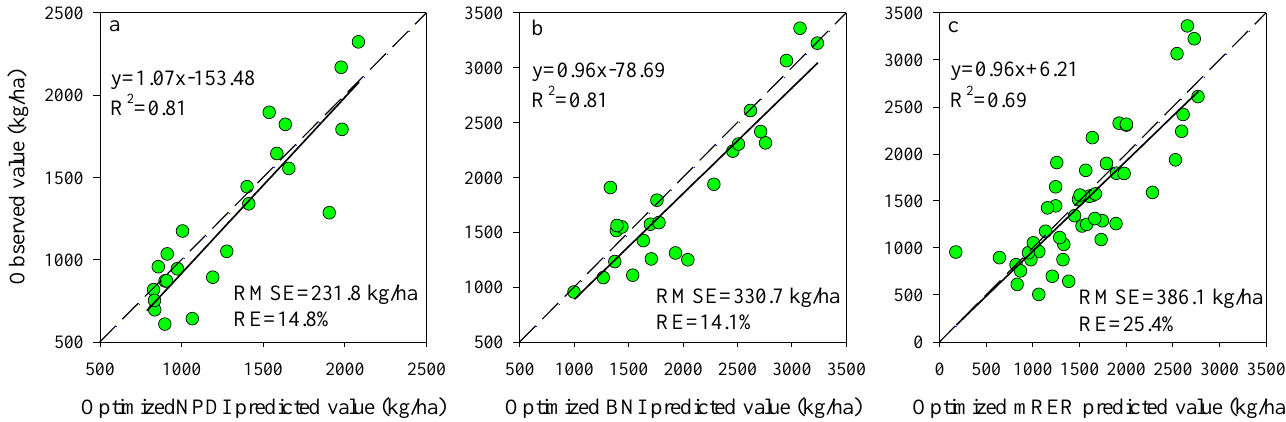
Figure 3. The relationships between the observed value and predicted value for the testing datasets using the best Opt-SIs at ( a ) tuber formation stage, ( b ) tuber bulking stage, and ( c ) the combination of growth stages.